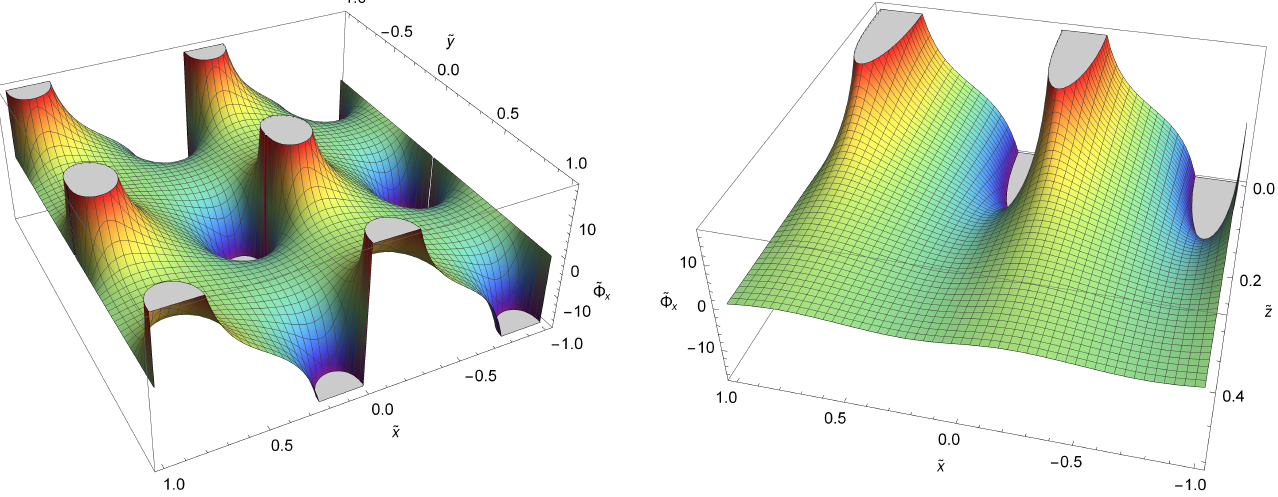
Figure 8. x -component of the rescaled force ˜ Φ x for ˜ λ eff = 3 for the sections z = 0 (left panel) and y = 0 (right